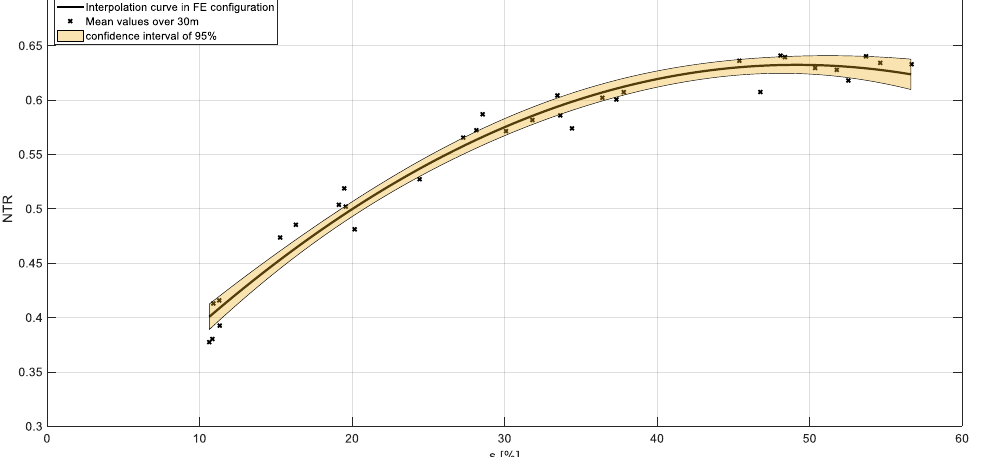
Figure 3. Regression analysis for net traction ratio ( NTR ) as a function of s for tractor configuration FE. The experimental data points, the regression curve R2 and the upper and lower prediction bounds (95% confidence level) are visible. The yellow-shaded region is the area used for data comparison.